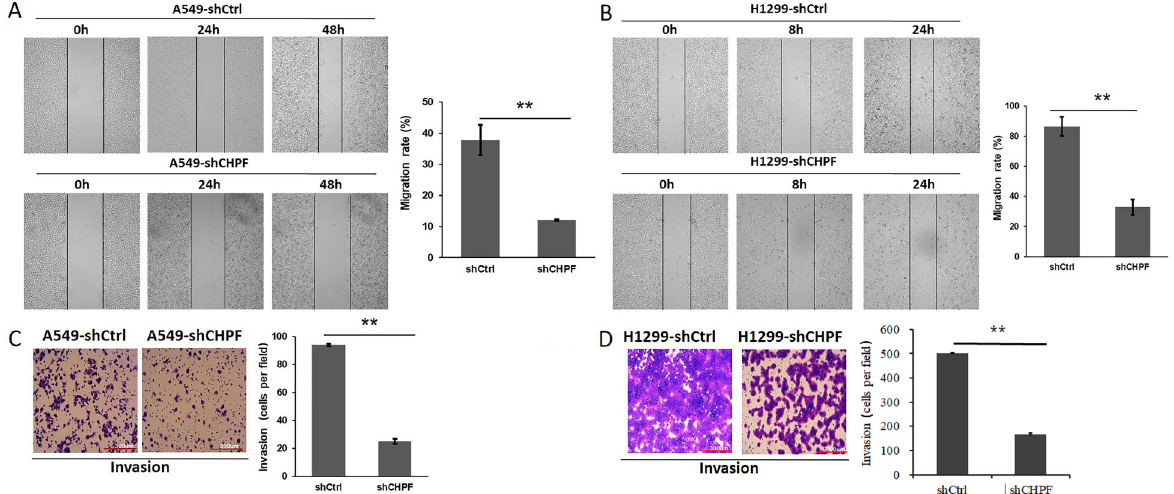
Figure 5. Effect of chondroitin polymerizing factor ( CHPF ) on the migration and invasion of A549 and H1299 cells. A, and B, A wound healing assay was applied to measure the number of migratory A549 and H1299 cells at the indicated time points. The cell invasive ability of A549 ( C ) and H1299 cells ( D ) was determined by the transwell assay after infection (scale bar: 300 m m). Data are reported as means ± SD of three independent experiments. **P o 0.01 (Student ’ s t -test).